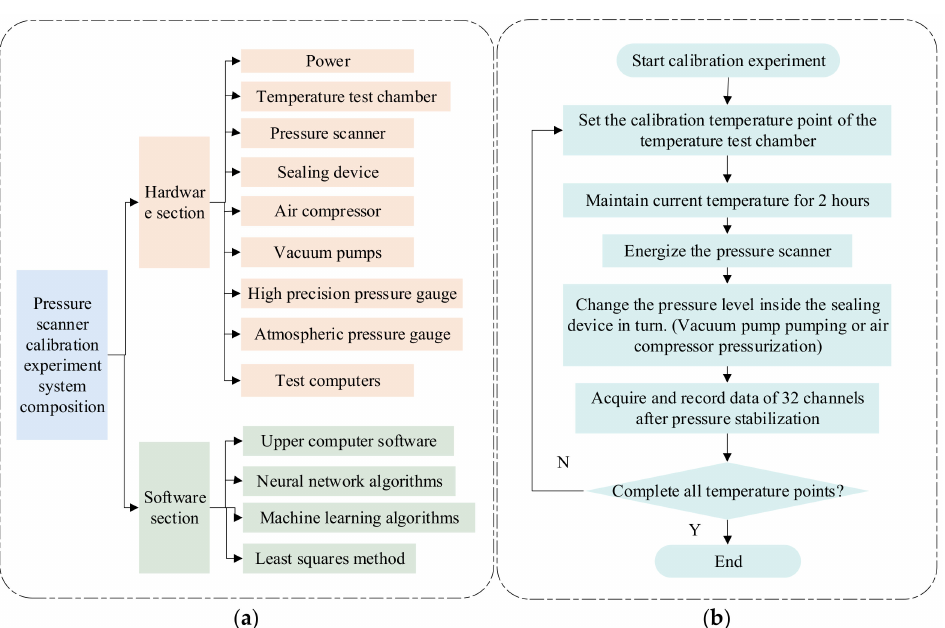
Figure 4. ( a ) Multi-channel pressure scanner calibration experiment system composition diagram. ( b ) The procedure of the